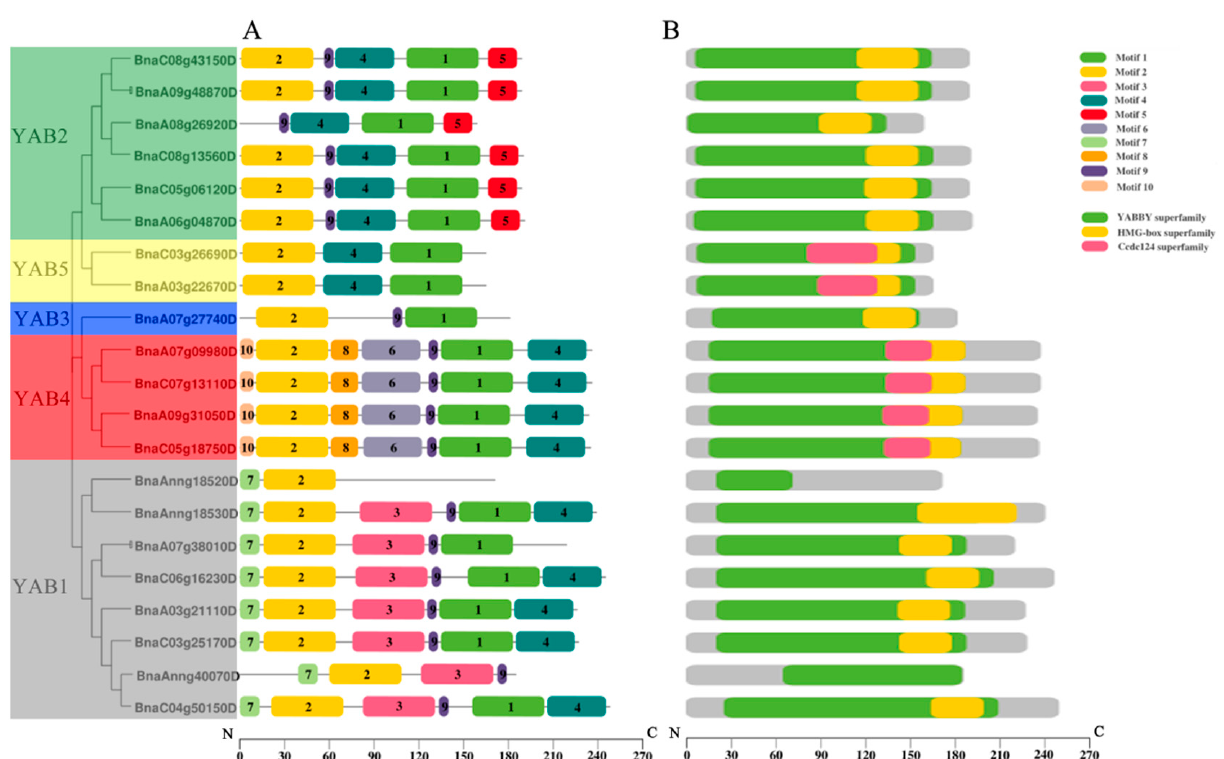
Figure 4. Analysis of protein motifs and conserved domains in B. napus YABBY proteins. ( A ) Protein motifs. Conserved motifs in the 21 BnaYAB proteins, arranged based on their phylogenetic positions. Weblogo plots of the ten conserved motifs are shown in Figure S1. ( B ) Conserved domains. Conserved domains are represented by different colored boxes.